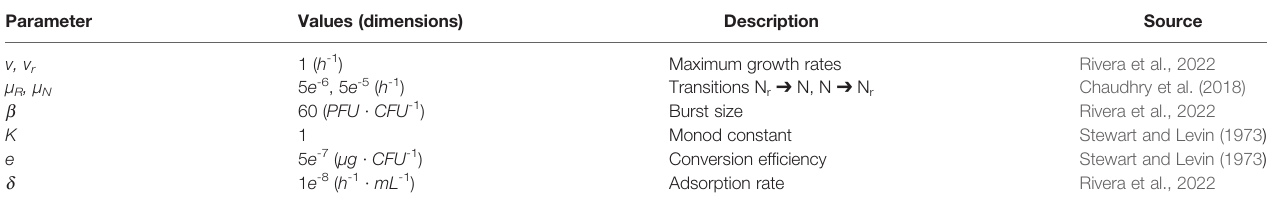
TABLE 1 | Simulation parameters used in the mathematical model.